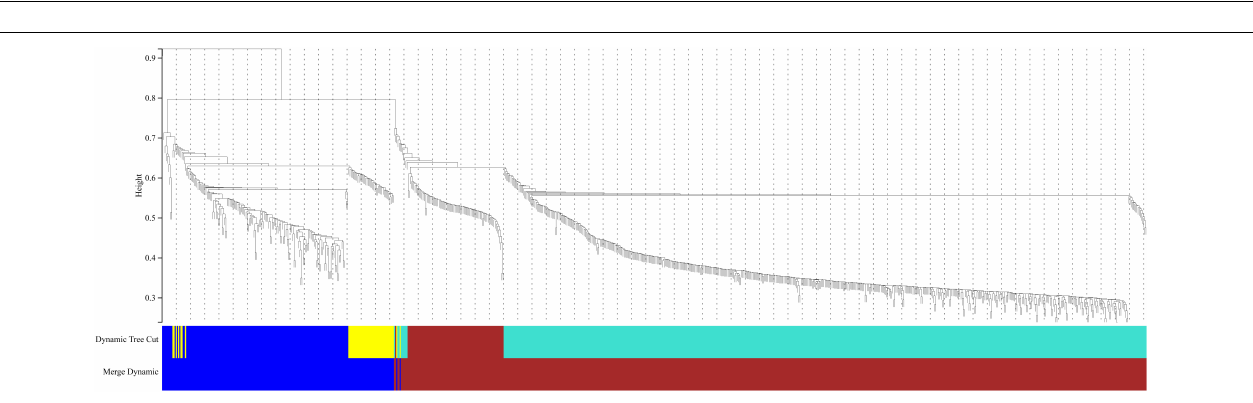
FIGURE 2 | Cluster dendrogram of genes in the GSE109887 datasets. Gene dissimilarity based on 1-TOM. Different colors represent different modules of gene clustering.